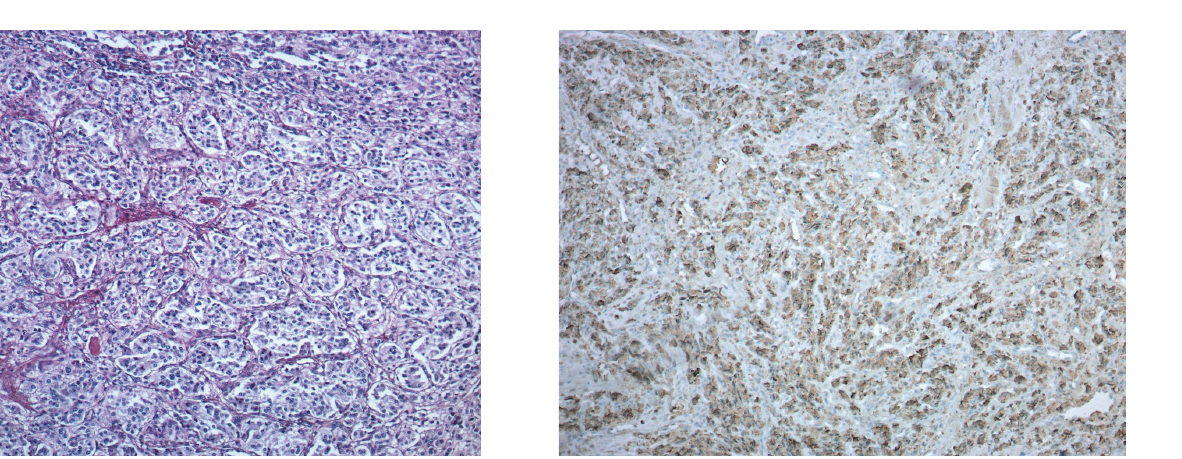
Figure 2: Pathology from leftadrenal. H&E (100x). Classic pattern of small nests (zellballen) made up of polygonal neuroendocrine cells(chiefcells).Thenestsareseparatedbyinterspersedsmallblood vessels and sustentacular cells.